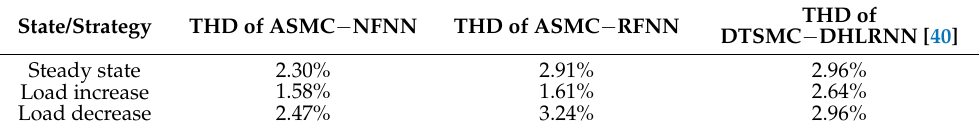
Table 2. THD comparison in simulation.